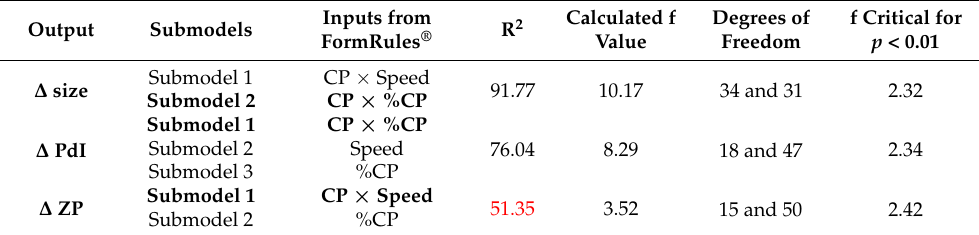
Table 2. Inputs selected by NFL models that explain ∆ Size, ∆ PdI, and ∆ ZP in lyophilized NLCs’ formulations, along with predictability (R 2 ) and ANOVA parameter (f: critical value of the f dis- tribution). The most relevant submodel is bolded, while models not meeting quality criteria are highlighted in